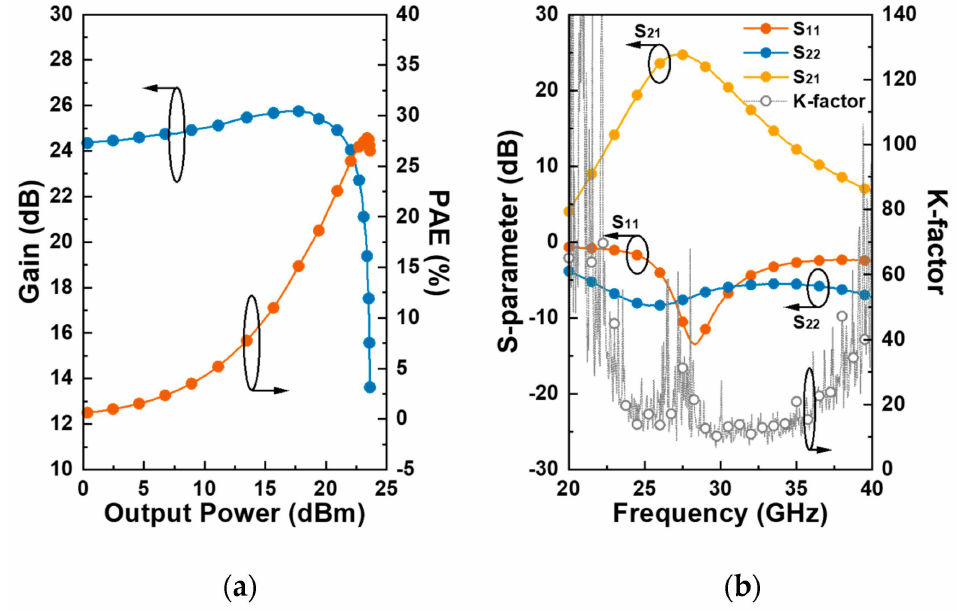
Figure 14. Measurement results: ( a ) gain and PAE and ( b ) S-parameters.